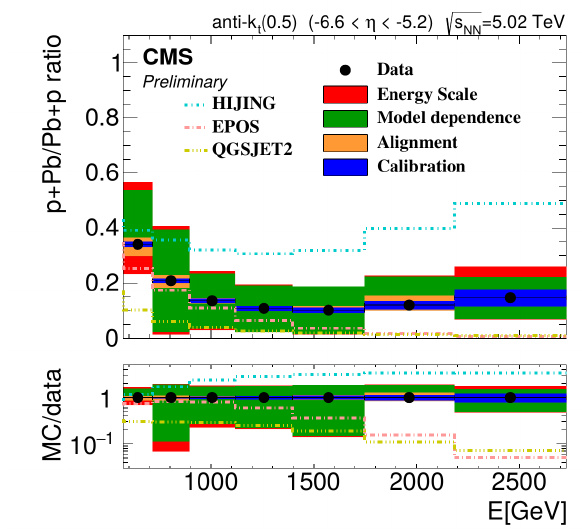
Figure 9. The average number of charged particles as function of central Z p T , see Ref. [12], in proton-proton collision of di ff erent centre-of-mass energies.